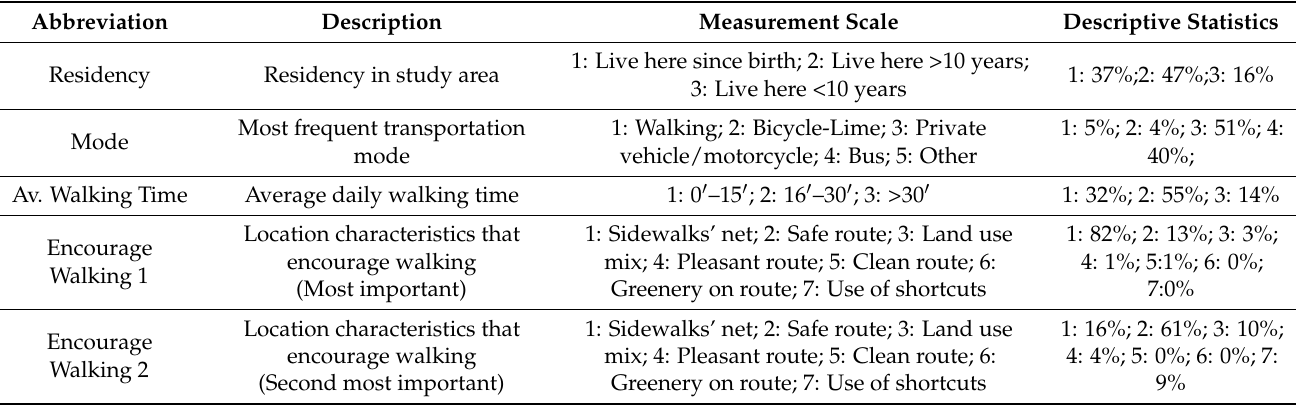
Table A1. Questions included in the